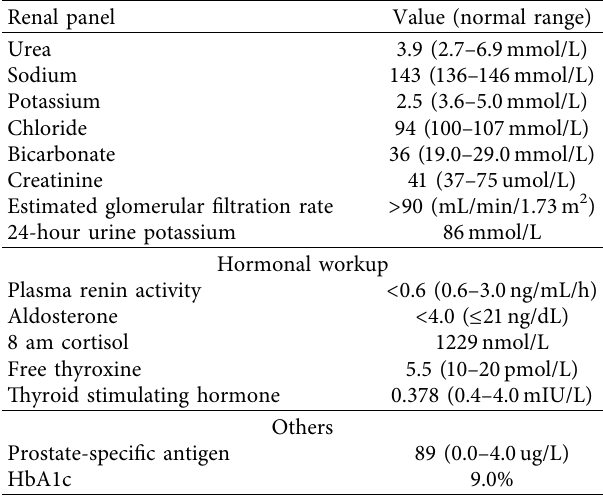
Table 1: Investigations done during his 2 nd